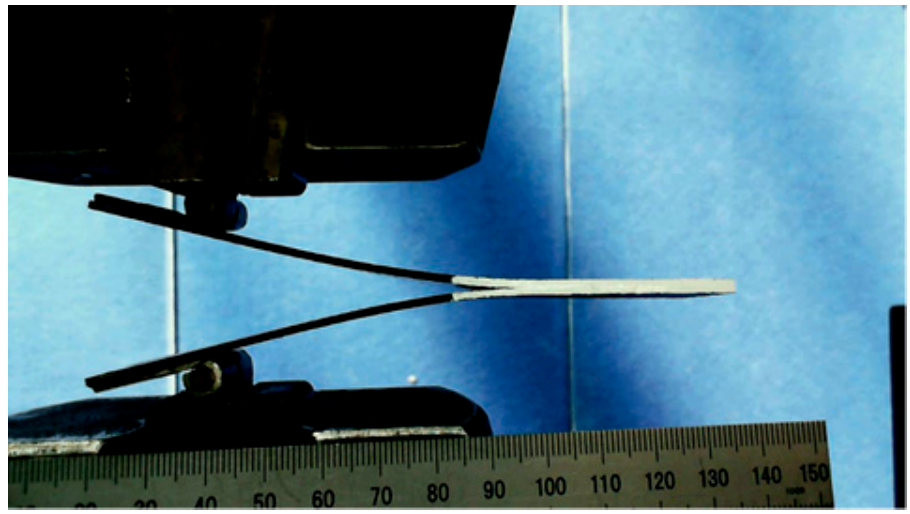
Figure 3. Representative snapshot during the Mode-I test.